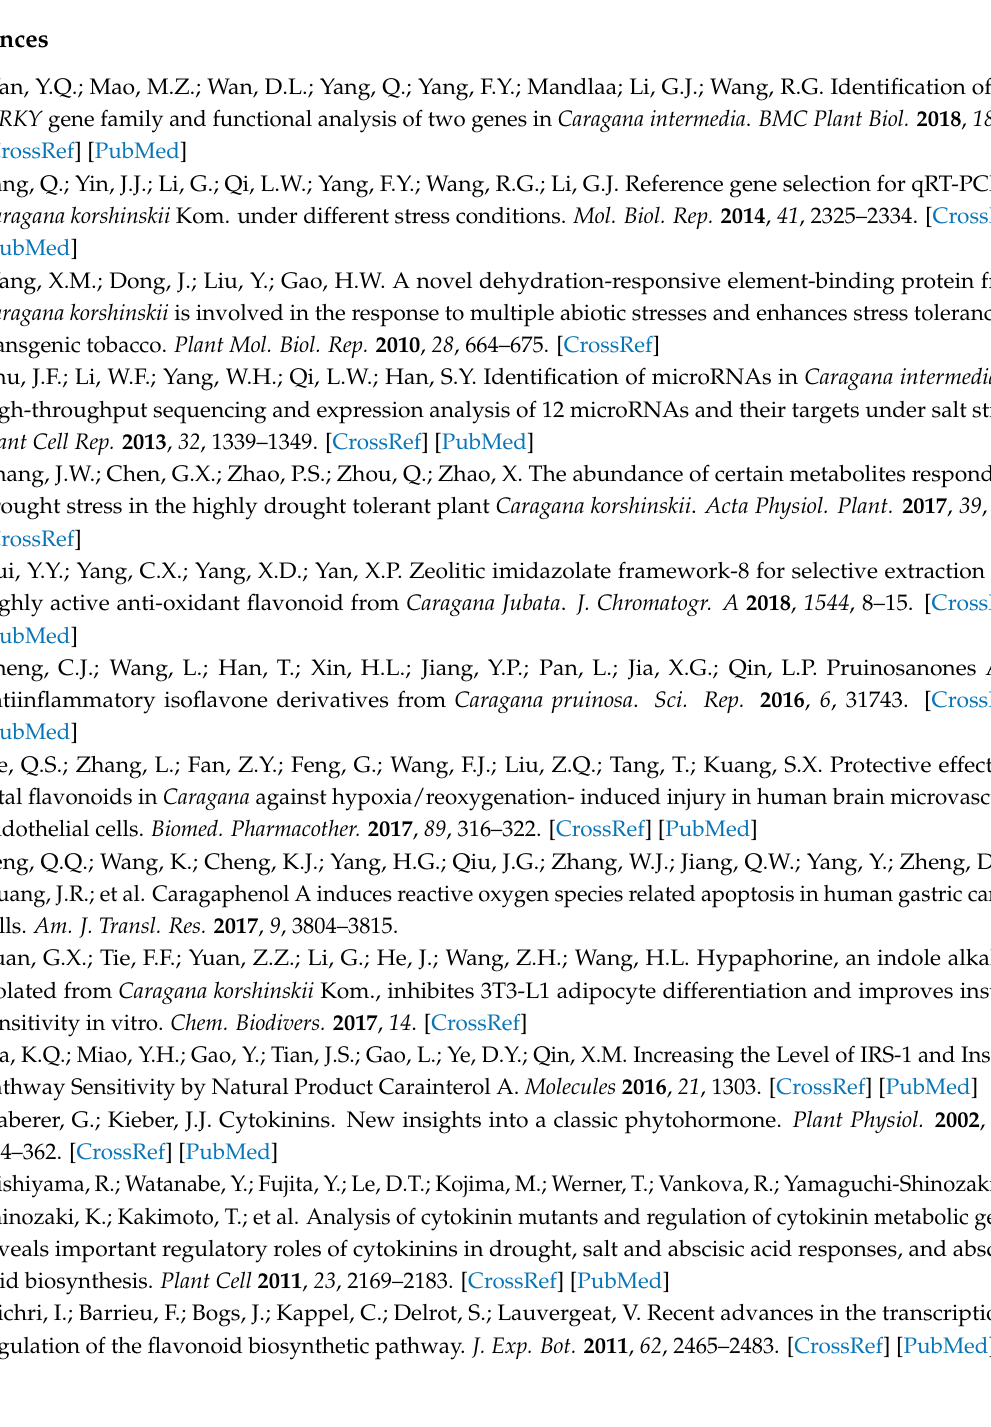
Supplementary Materials: The following are available online. Table S1: Summary of information on metabolites in samples, Table S2: Distinct metabolites information of 30-day-old pods, Table S3: The standard curves of rutin and